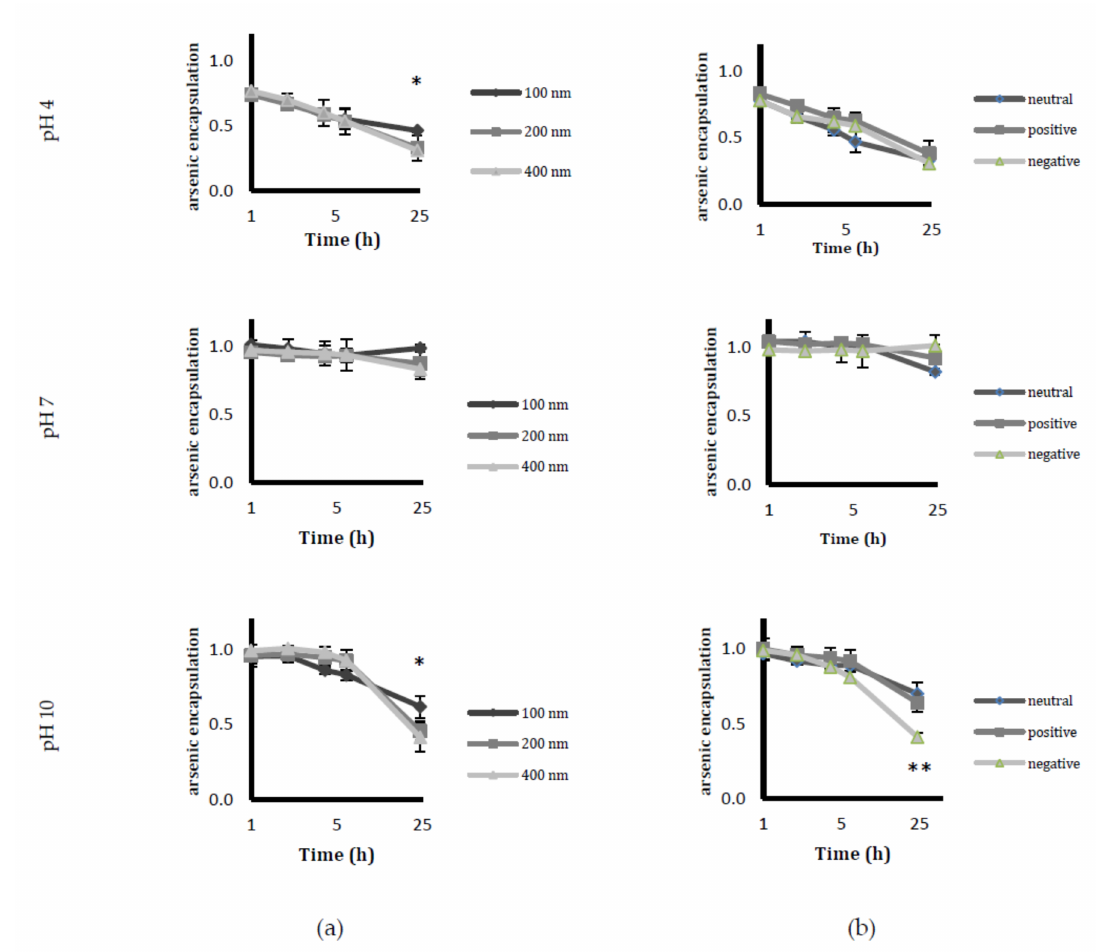
Figure 2. Stability studies of different liposomal formulations under various pH conditions. Arsenic trioxide (ATO) was encapsulated in liposomes of ( a ) different sizes and ( b ) different charges after dialysing in buffers at pH 4, pH 7, and pH 10. Data are shown as mean ± SD of three independent experiments; * p < 0.05, ** p <